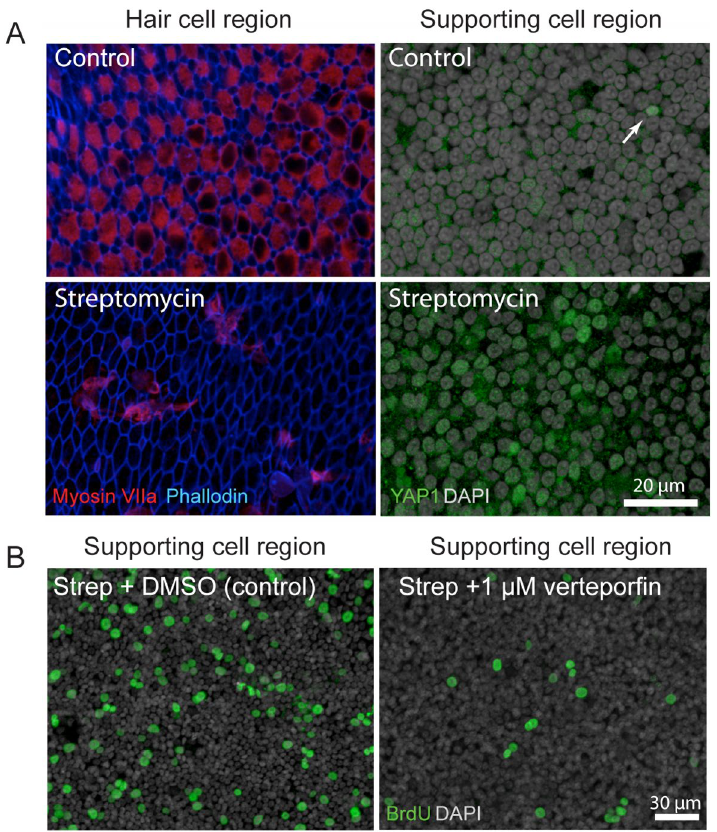
Figure 7. YAP1 response to ototoxic injury in organotypic cultures of the chick utricle. ( A ) Left: Utricles that were maintained in culture for 24 h in 1 mM streptomycin showed extensive loss of hair cells (blue, phalloidin), when compared to control cultures. Right: This hair cell lesion was accompanied by enhanced nuclear translocation of YAP1 (green) in remaining supporting cells. ( B ) Some utricles were allowed to recover for 48 h after streptomycin treatment, and proliferating cells were labeled with a 24 h pulse of BrdU (green). Numerous BrdU-labeled cells (green) were observed in streptomycin-injured utricles. However, addition of verteporfin caused a reduction in proliferating cells (p = 0.0008, see text for